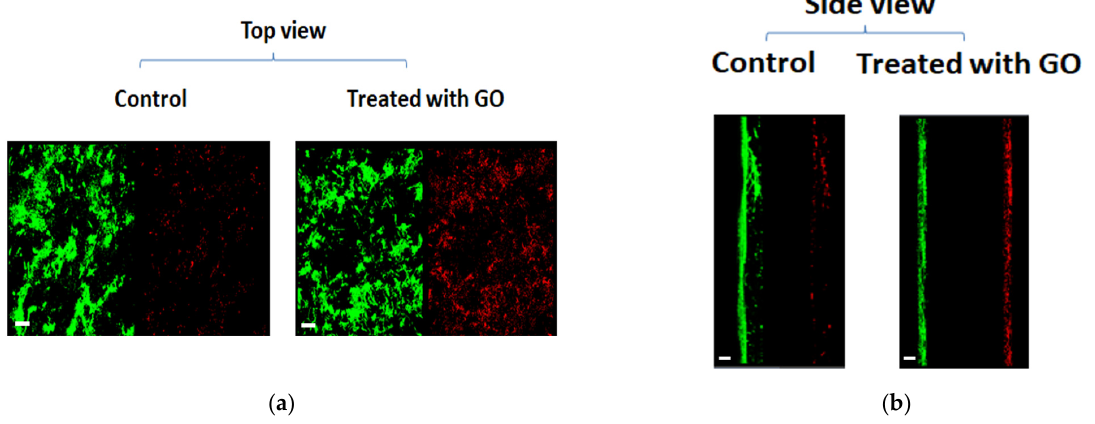
Figure 6. Confocal images of P. putida biofilm with or without GO (85 μ g/mL) following 48 h incu ‐